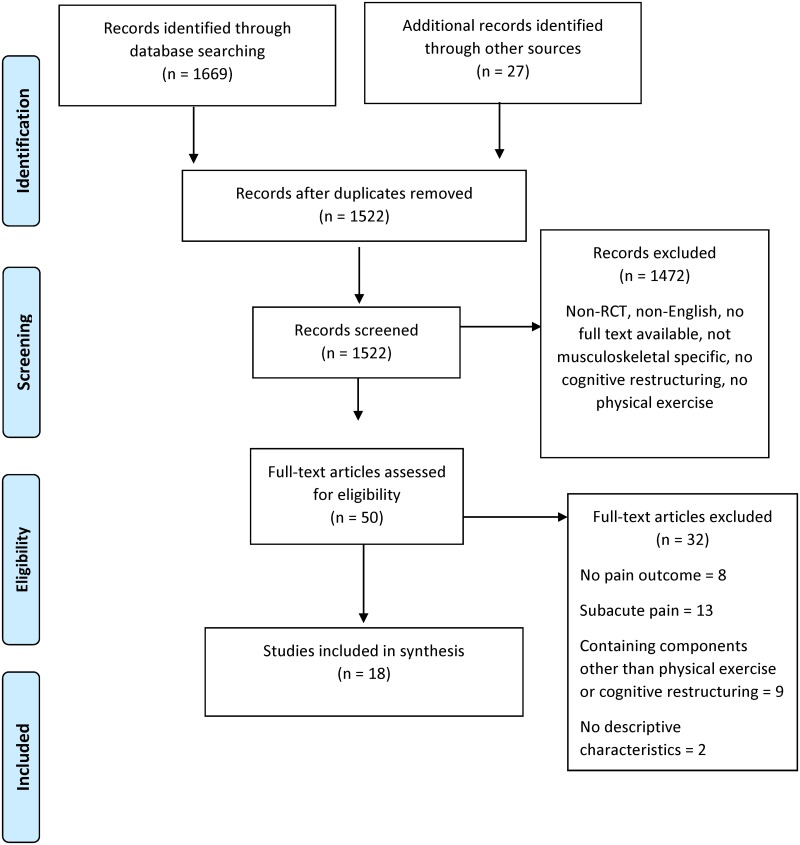
Flow chart of literature search.